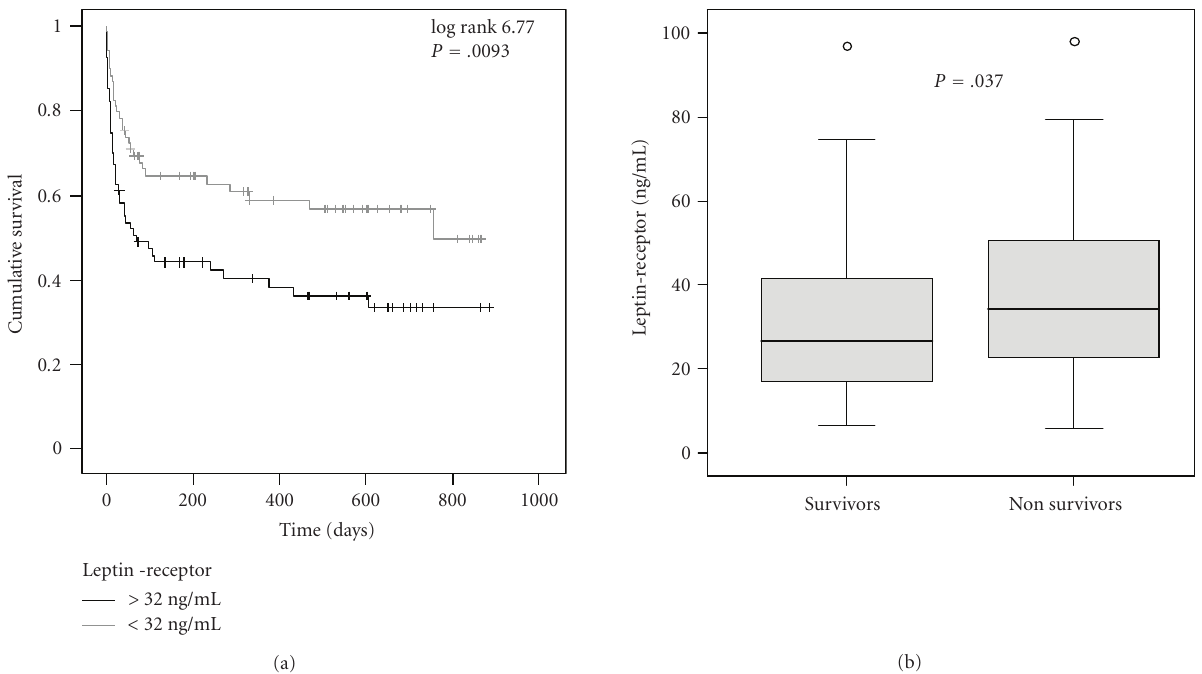
Figure 3: Prognostic relevance of serum leptin-receptor in critically ill patients. (a) Kaplan-Meier survival curves of ICU patients ( n = 137) are displayed, showing that patients with high leptin-receptor levels ( > 32ng/m/L, black) have an increased mortality as compared to patients with low serum leptin-receptor ( ≤ 32ng/mL, grey). P -value from Cox regression analysis is .034. (b) Patients that die during follow-up period treatment ( n = 71, 51.8%) have significantly ( P = . 037) higher serum leptin-receptor levels on admittance to ICU than survivors ( n = 66, 48.2%). Box plot are displayed, where the dotted line indicates the median per group, the box represents 50% of the values, and horizontal lines show minimum and maximum values of the calculated nonoutlier values; asterixes and open circles indicate outlier